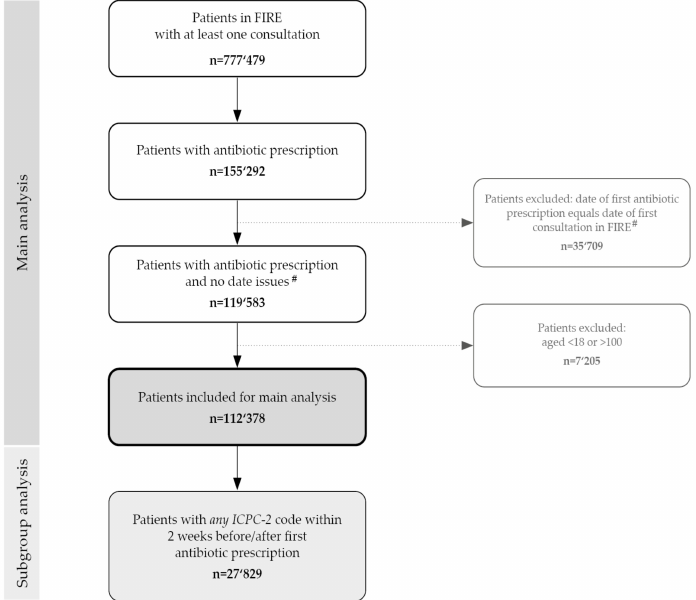
Figure 1. Event flow chart. Number of patients with antibiotic prescriptions in Swiss primary care from the FIRE database. FIRE, Family Medicine ICPC-Research using EMR; EMR, Electronic Medical Records; ICPC, International Classification of Primary Care (-2) code system. #Date issues: when the date of a first antibiotic prescription coincided with the date of a first consultation; a prescription